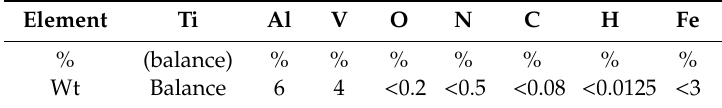
Table 1. Chemical composition of Ti6Al4V alloy powder used for SLM.